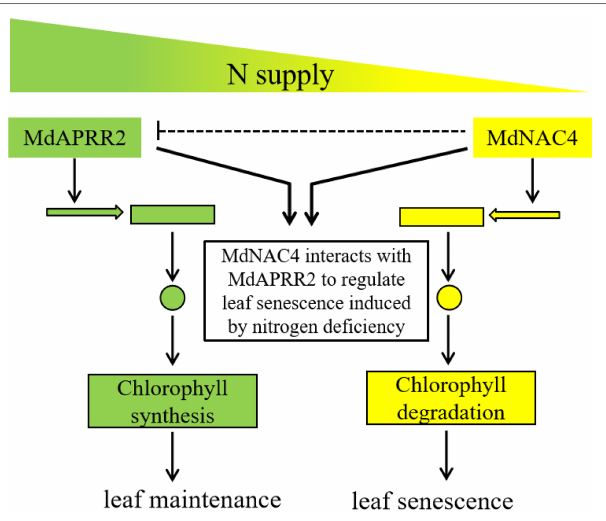
FIGURE 7 | Working model of MdNAC4 regulating N deficiency-induced leaf senescence. The expression of CCGs (yellow) is upregulated, while the expression of chlorophyll synthesis genes (green) is downregulated under nitrogen-deficient conditions. The expression of MdAPRR2 target genes (green) is downregulated in the presence of MdNAC4 protein, which leads to the inhibition of chlorophyll synthesis, while the expression of MdNAC4 target genes (yellow) is upregulated, which accelerates chlorophyll